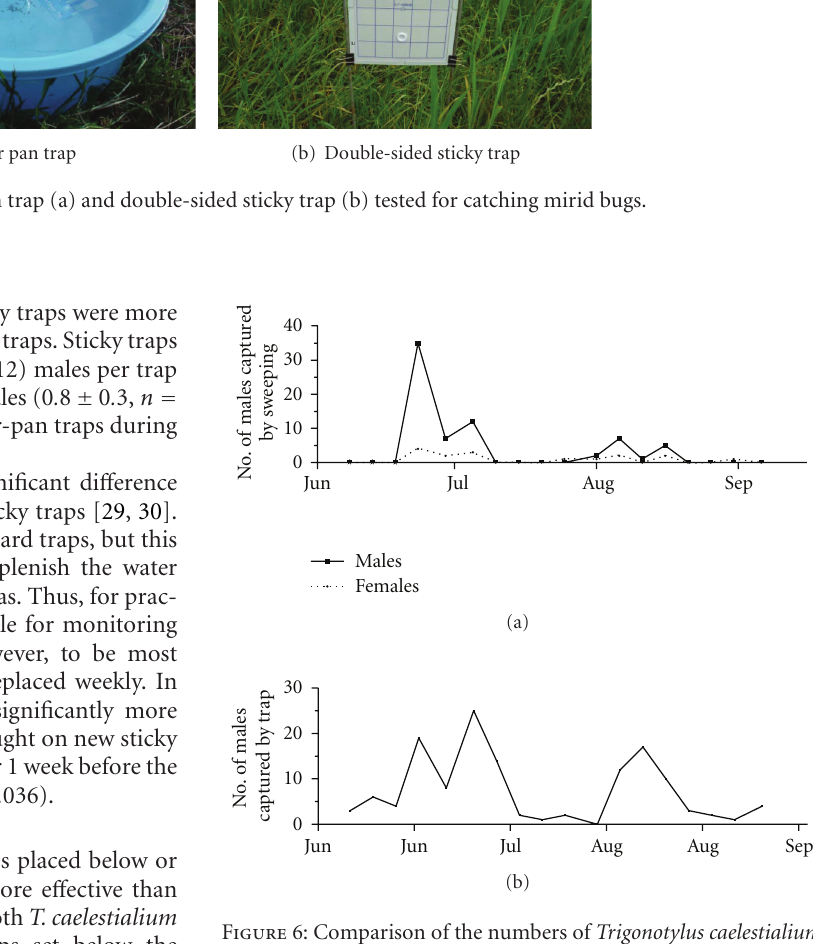
Figure 6: Comparison of the numbers of Trigonotylus caelestialium males caught by sweep-net sampling (a) or by a pheromone-baited sticky trap placed in the center of the paddy field (b). Sweep-net samples were taken 18 times at 5 d intervals. Data were modified from